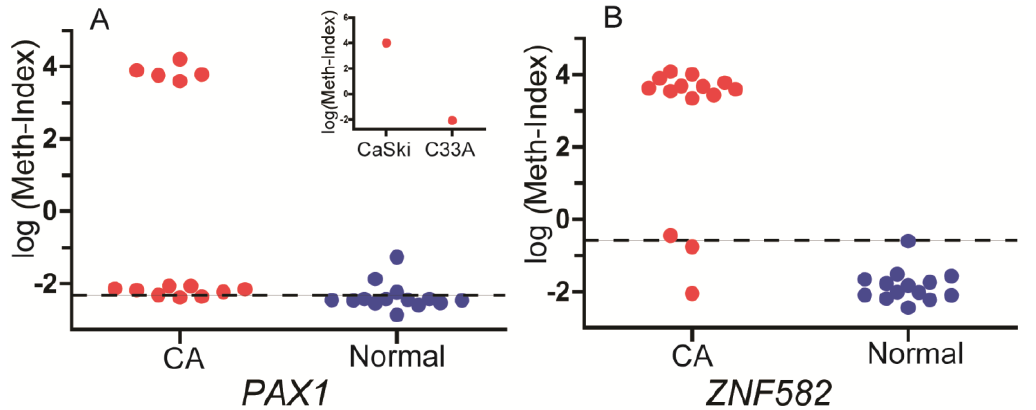
Figure 1. The levels of PAX1 ( A ) and ZNF582 ( B ) methylation in cancer (CA) and paracancerous (normal) tissues from 14 esophageal squamous cell carcinoma (ESCC) patients. The level of DNA methylation is presented as log (meth-index). Insets image shows the log (meth-index) of PAX1 for CaSki and C33A cell lines, which were used as methylation and non-methylation controls, respectively. The cut-off value is shown as a dashed line.